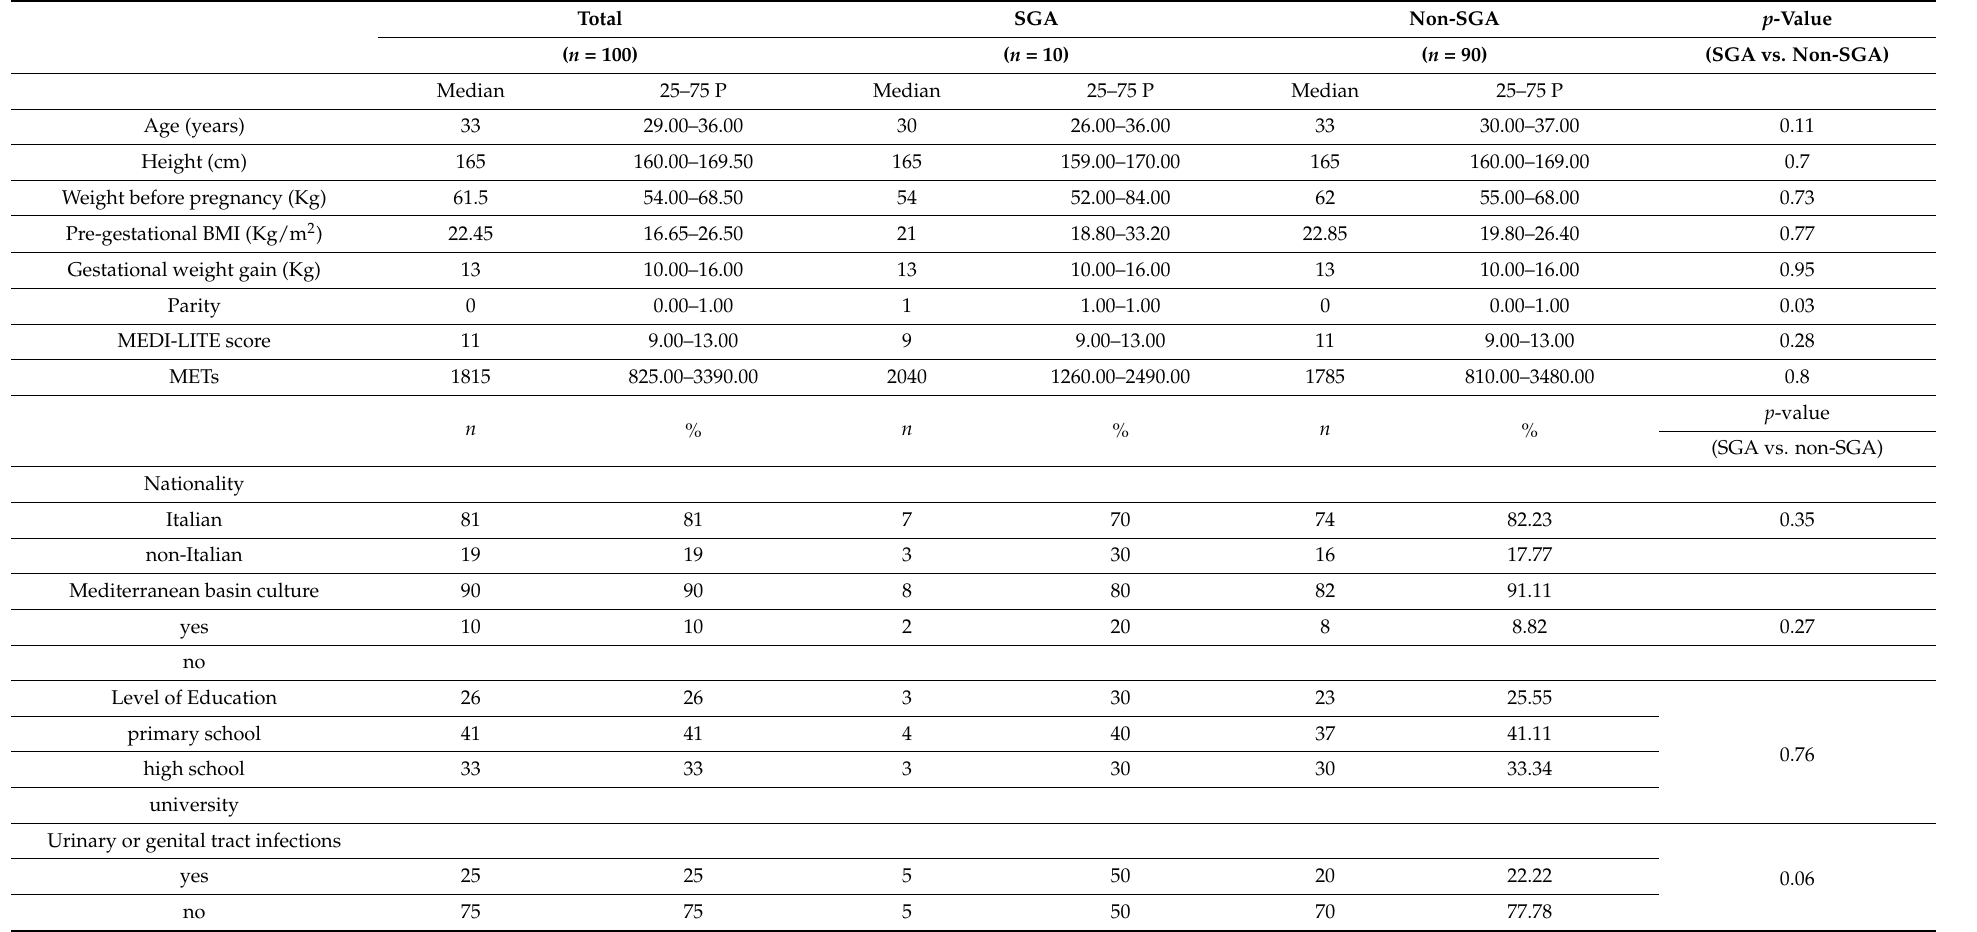
Table 1. Characteristics of the study